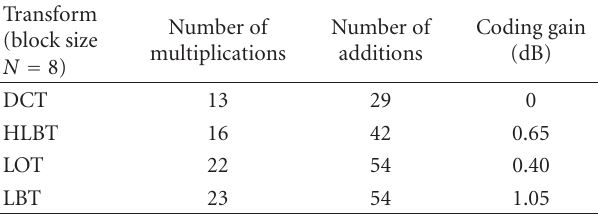
Table 2: Comparing computation complexity and coding gain with 0.3bits/sample of four transformations with Gauss-Markov input and intersample autocorrelation coe ffi cient ρ ≈ 0 . 95 per